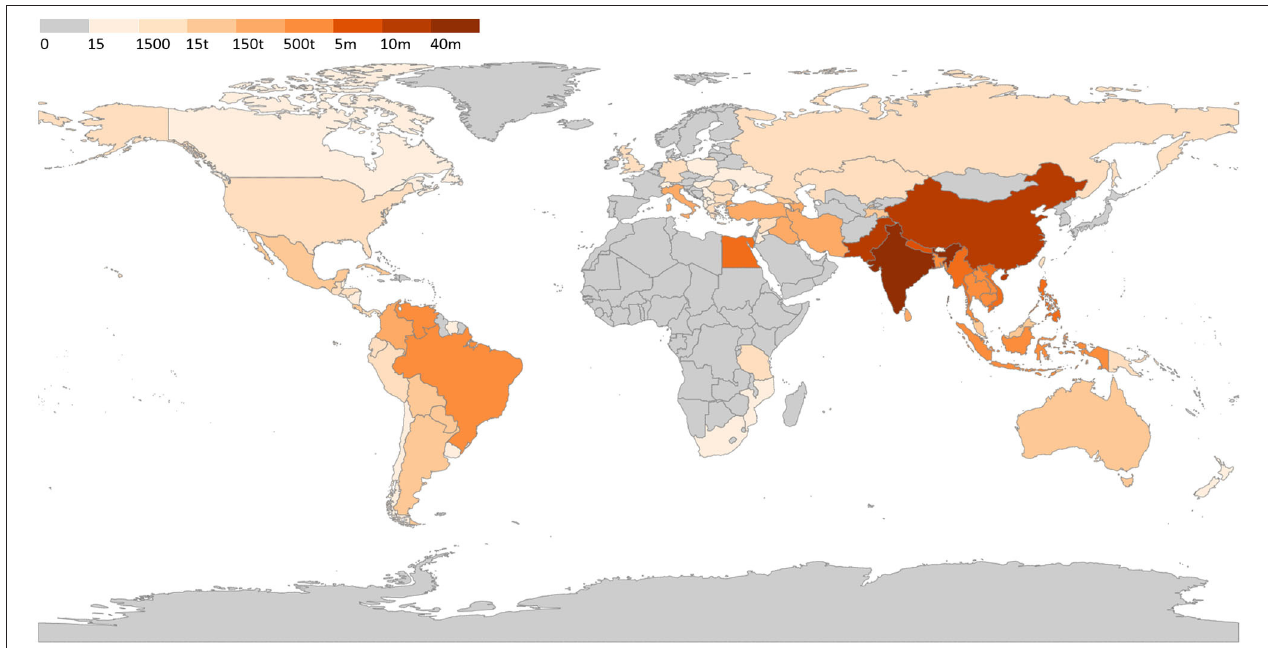
FIGURE 4 | Water buffalo population worldwide. Legend indicate number of head in each country; t, thousand; m, million. Data source available at Supplementary Table 1